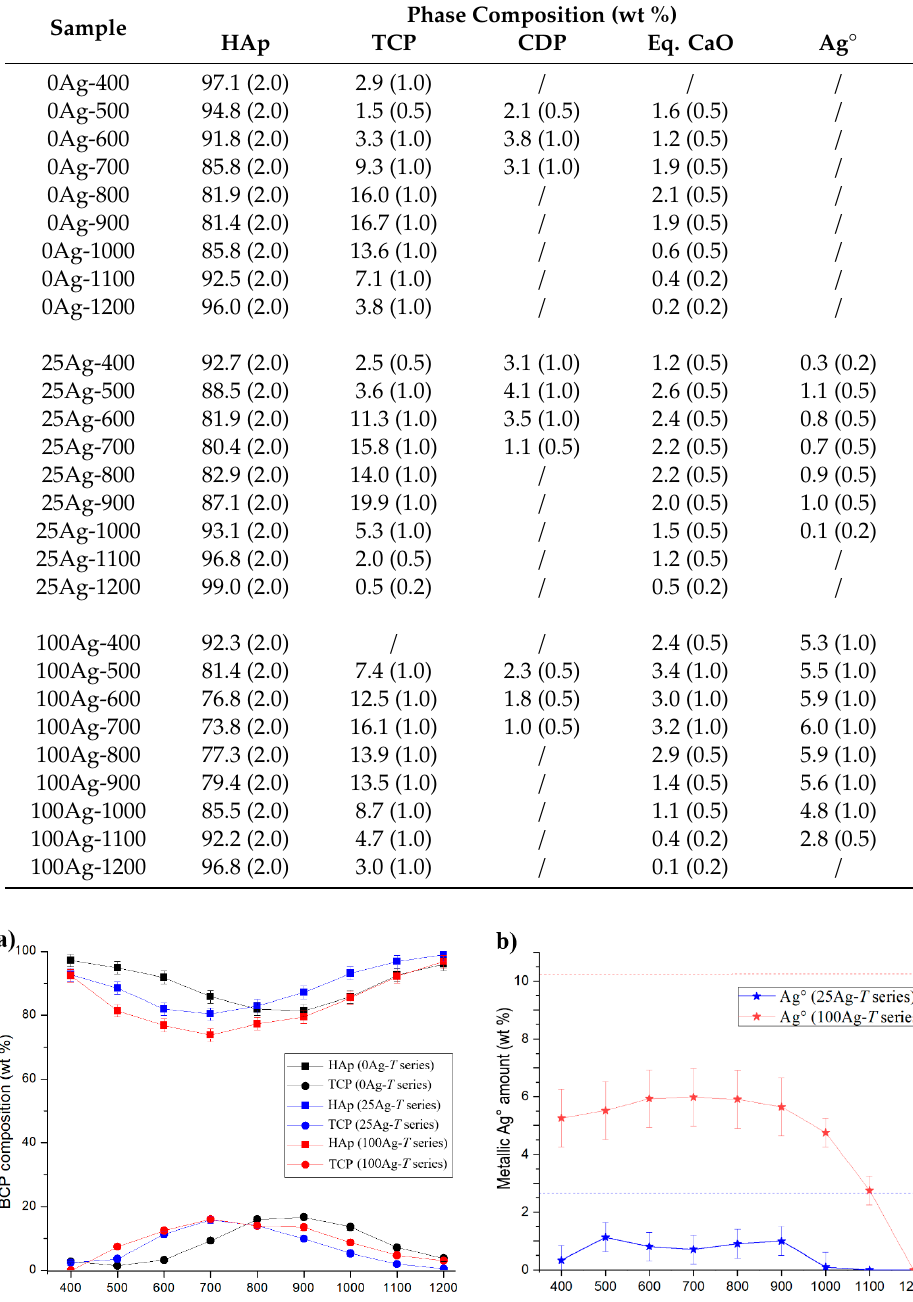
Table 1. Quantitative phase analysis (wt %) of the 27 samples; standard deviations are indicated in brackets (CDP: Ca 2 P 2 O 7 and ‘Eq. CaO’ considers both the CaO and CaCO 3 amounts).